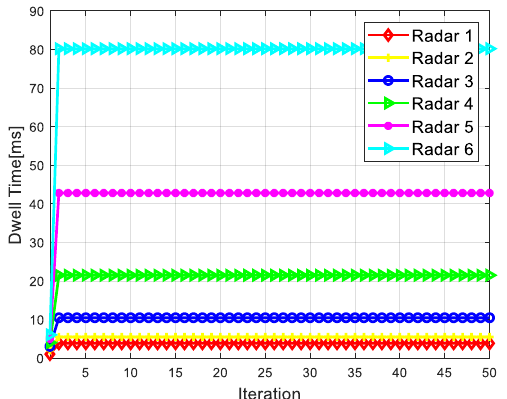
Figure 8. Radar dwell time convergence performance.